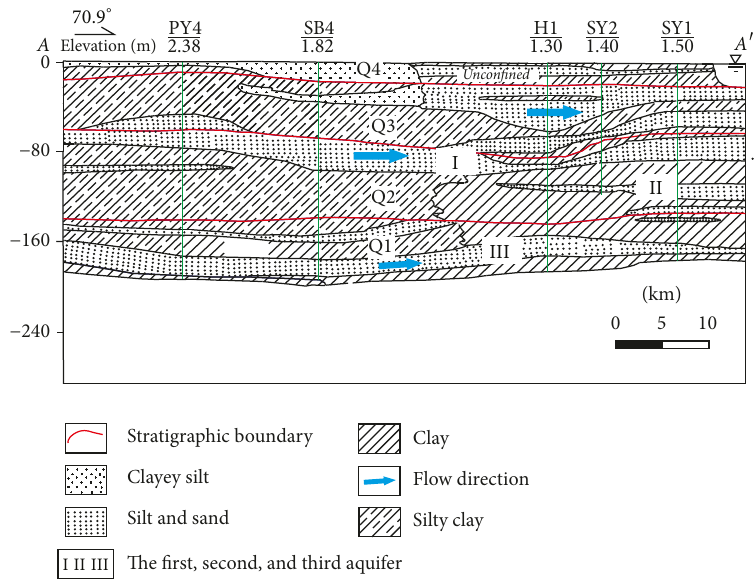
Figure 2: A–A 󸀠 cross section of the study area (modified after Fu [20]). I, II, and III represent first, second, and third confined